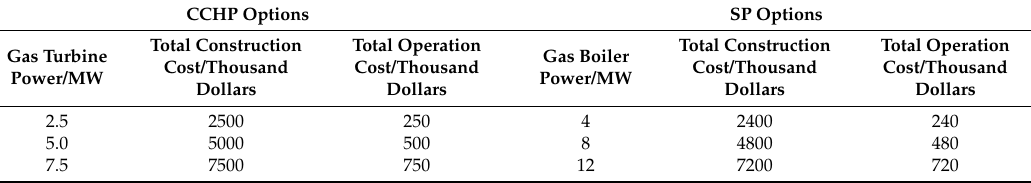
Figure 9. SP physical planning model. Table 1. Candidate options of CCHP and SP.